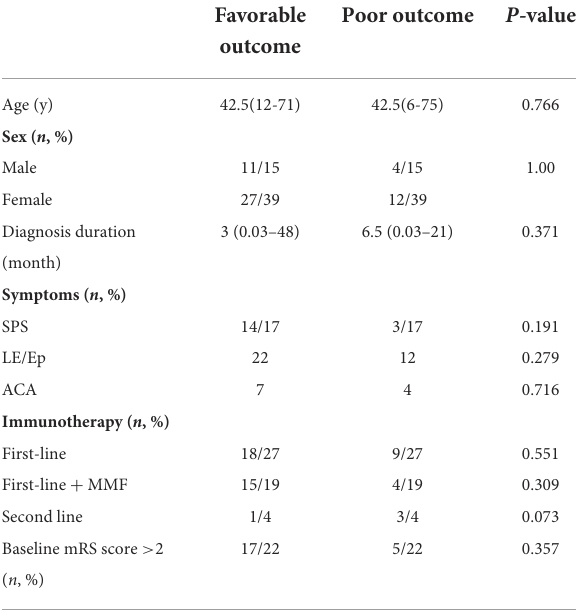
TABLE 3 Comparisons of the clinical data of the patients with GAD65-ab-associated neurological disorders.